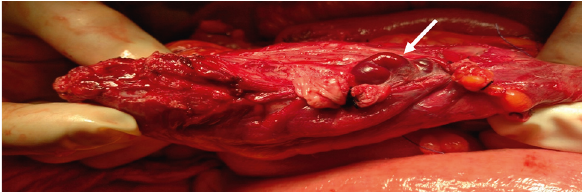
Figure 3: The ileum with the identified varix.